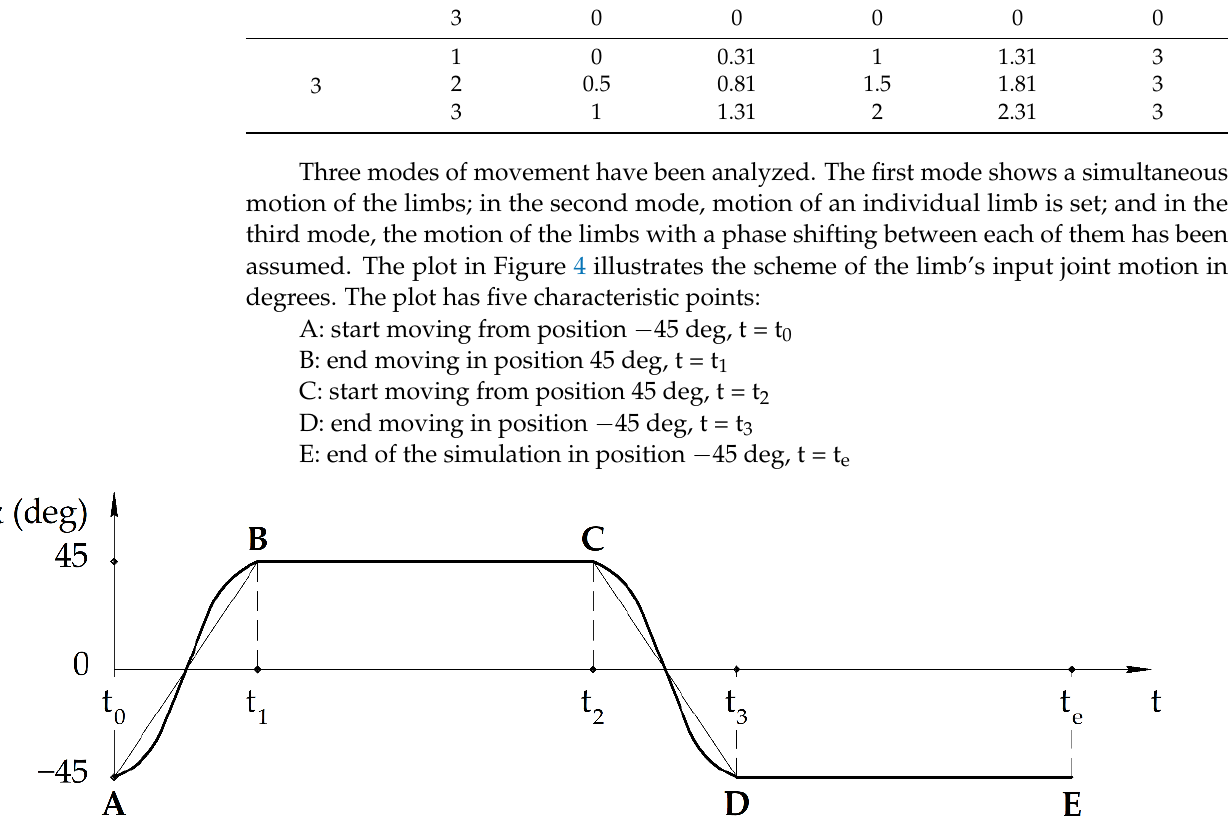
Figure 4. A scheme for input motion mode of the limbs